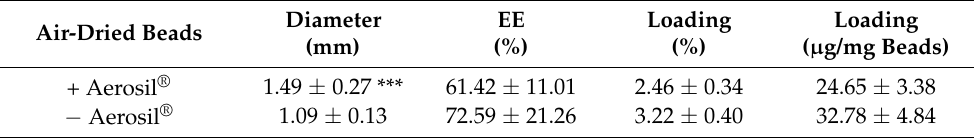
Table 2. Size, EE, and loading of air-dried insulin loaded-beads, with or without Aerosil ® . Data presented as mean ± SD, n =